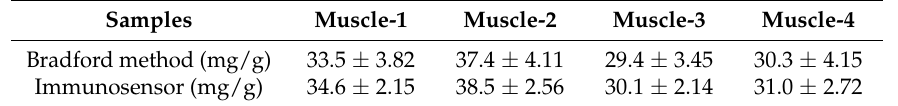
Table 1. Comparison of Bradford method and the immunosensor obtained in practical samples.